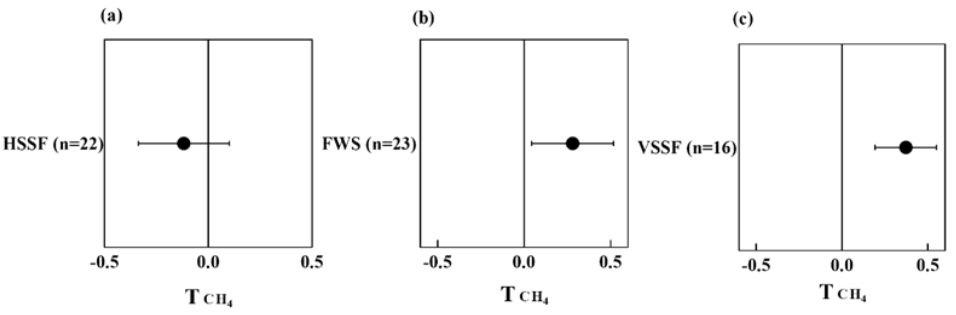
Figure 4. Effect on T index of CH 4 emission from different types of vegetated CWs, i.e., HSSF ( a ), FWS ( b ), and VSSF ( c ), compared to unvegetated CWs.